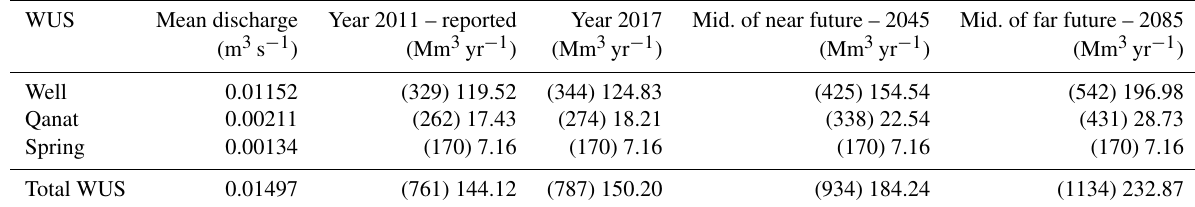
Table 3. Projected water demand from water use systems. The number of water use systems mentioned in parentheses is estimated based on population growth in 2017 and in the near and far